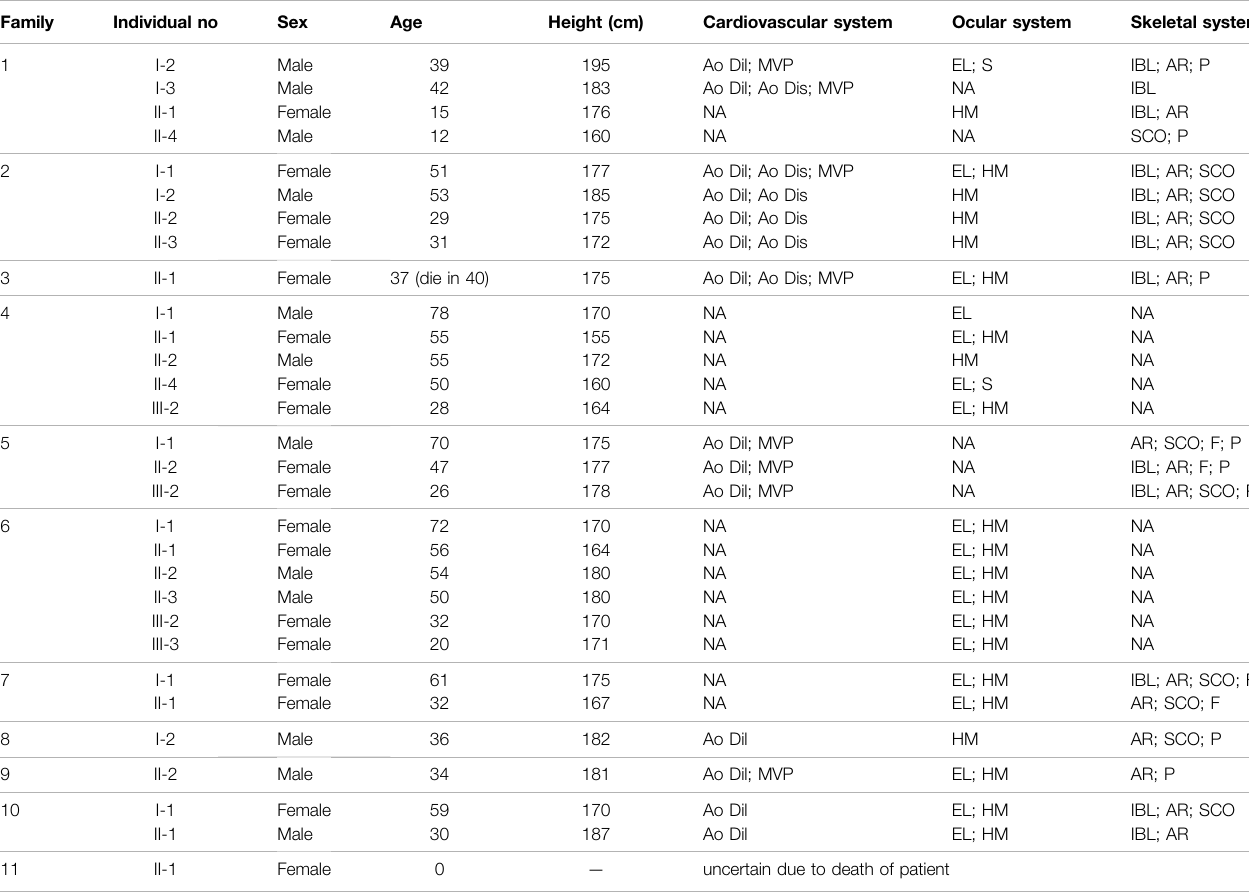
TABLE 1 | Clinical features of fi brillin-1 ( FBN1 ) mutation patients in 11 Marfan families. Family Individual no